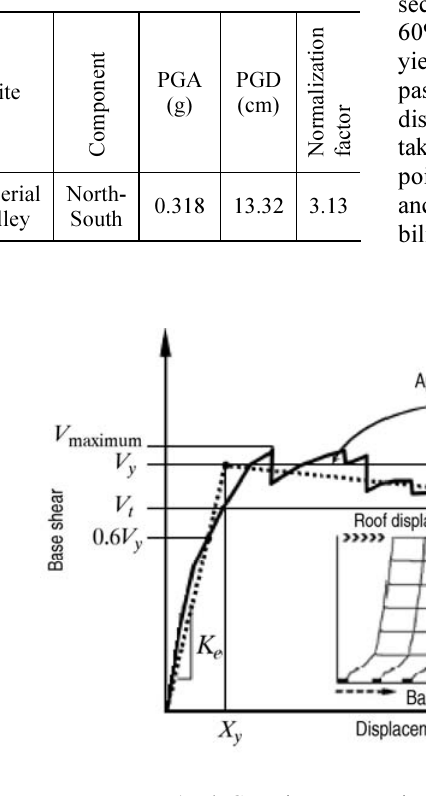
Fig. 4. Capacity curve vs. its